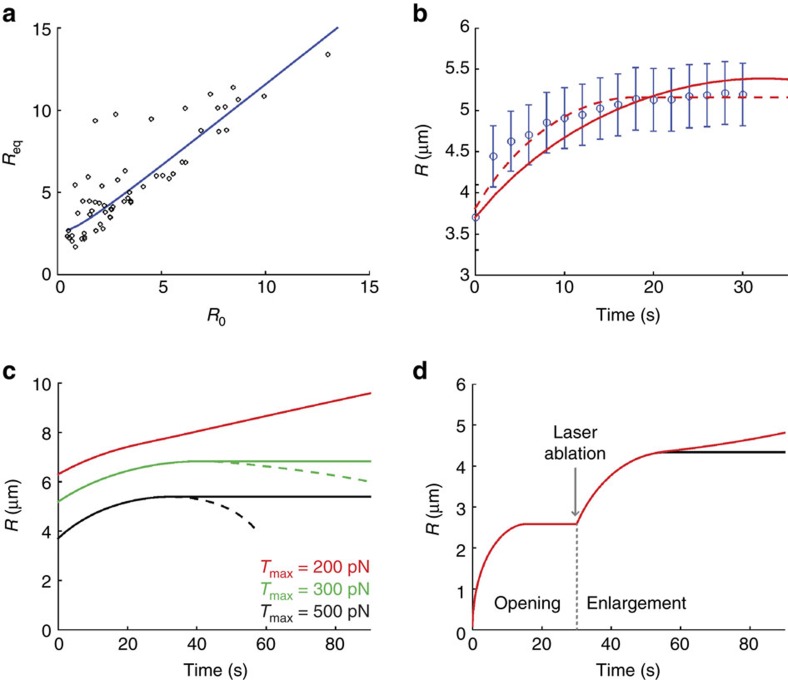
Physical interpretation of TEM enlargement after laser ablation.(a) Comparison of the experimentally observed TEM opening after ablation and the model’s predictions. The plot represents the final equilibrium radius, Req, versus the initial radius before ablation, R0. The model is run using the standard parameter values discussed in the text ( N m−1, μ=108 Pa s m−1,  N s−1). (b) Comparison of the experimentally observed dynamics of TEM opening under control conditions (blue symbols; mean±s.e.m.) with the theoretical model’s prediction, obtained using the standard parameter values of the physical parameters indicated in the text (solid red line) and using parameter values fitted to the data (dashed red line:  N m−1, μ=108 Pa s m−1,  N s−1). (c) Effect of the maximum line tension, Tmax, on TEM opening dynamics. The plot shows the TEM size increase as a function of time for the standard parameter values with R0=3.7 μm (same as in plot b) and Tmax=500 pN (black curve); for standard parameter values with Tmax=300 pN and an initial R0 increased by a factor of 1.4, representing siEzrin experiments (green curve); and for a case with Tmax=200 pN and an initial R0 increased by a factor of 1.7, representing siNMII experiments (red curve). Because the model does not describe the TEM closure mechanism, the predicted closure dynamics is represented by dashed lines and replaced by horizontal solid lines. (d) Schematic representation showing the model’s prediction reproducing the two-phase TEM opening dynamics of an ablation experiment ( N m−1, μ=108 Pa s m−1,  N s−1). The red curve corresponds to a reduced line tension, such as in siEzrin conditions (Tmax=200 pN). The curve shows a TEM opening ex novo (from an initial R0=100 nm) and reaching a maximum equilibrium radius. If laser ablation is performed at the time indicated by the arrow, the TEM opens up again, without reaching a new equilibrium radius (red curve). In contrast, for a higher line tension (Tmax=500 pN, black curve), the TEM stabilizes again after laser ablation.